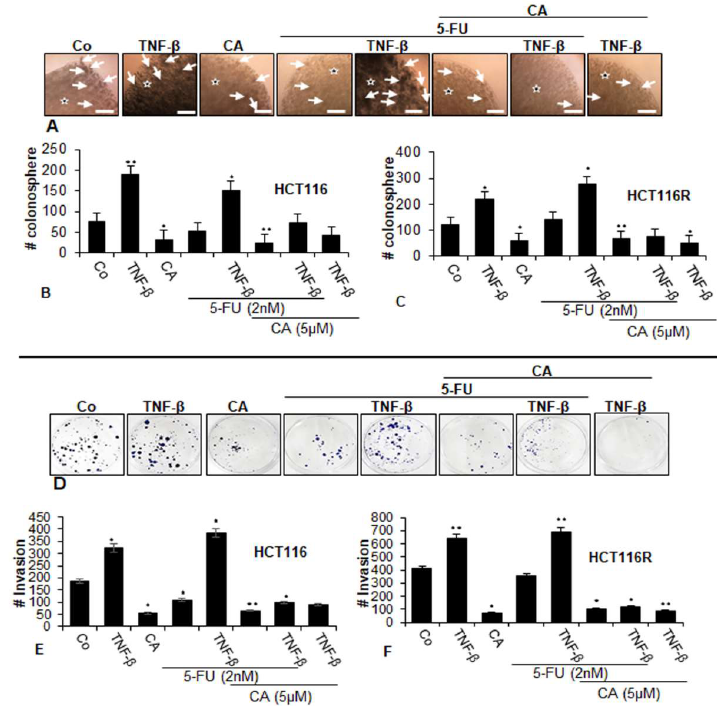
Figure 2. E ff ects of Calebin A and / or 5-FU on TNF- β -promoted colonosphere formation and migration in CRC cells in 3D-alginate tumor cultures. Serum-starved cultures of HCT116 ( A , B , D , E ) and HCT116R ( C , F ) cell lines in alginate matrix (stars) were treated as described in the Materials and Methods section. Colonosphere formation and migration were evaluated by light microscopy after 10 days. All experiments were performed at least three times. The number of colonospheres (arrows) was quantified by counting 100 cells from 20 di ff erent microscopic fields, and the number of invaded spheroids was quantified in each well. p < 0.05 (*) and p < 0.01 (**) indicate a significant di ff erence compared to the control group. Magnification A: × 24, scale bar = 0.2